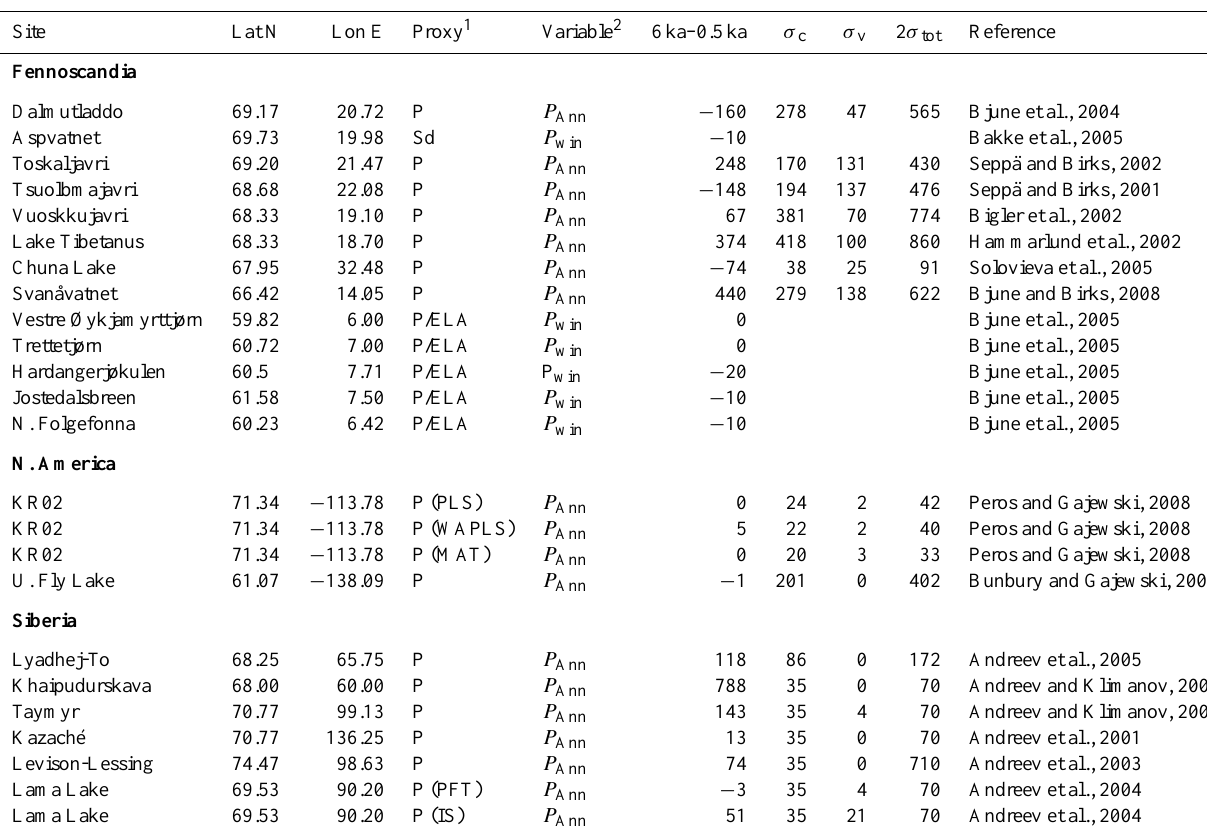
Table 1b. Precipitation reconstructions from proxy data discussed in this